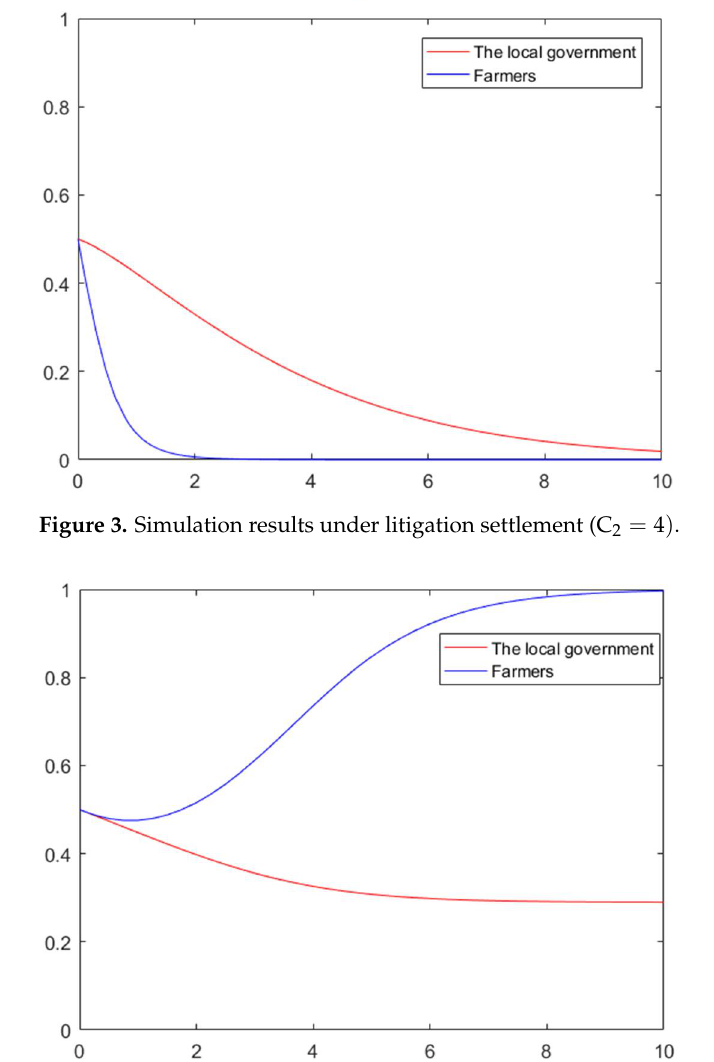
Figure 5. Simulation results under litigation settlement ( C (cid:2870) = 1,∆S (cid:2870) = 2.5) . It can be seen in Figure 5 that when the litigation costs of farmers are reduced and the rent-seeking ceiling of the local government is controlled, λ (cid:2869)(cid:2870) (V (cid:2869) + ∆S (cid:2870) − C (cid:2871) ) < λ (cid:2869)(cid:2870) (V (cid:2869) + I (cid:2869) ) , the local government gradually tends to compromise and the farmers gradu- ally tend to accept. At this time, the two sides of the game achieve the evolutionary equi- librium result of (compromise, acceptance), and the “government rent-seeking” farmland expropriation conflict is resolved. In addition, increasing the rent-seeking costs of the local government or the positive social externality benefits under reasonable expropriation